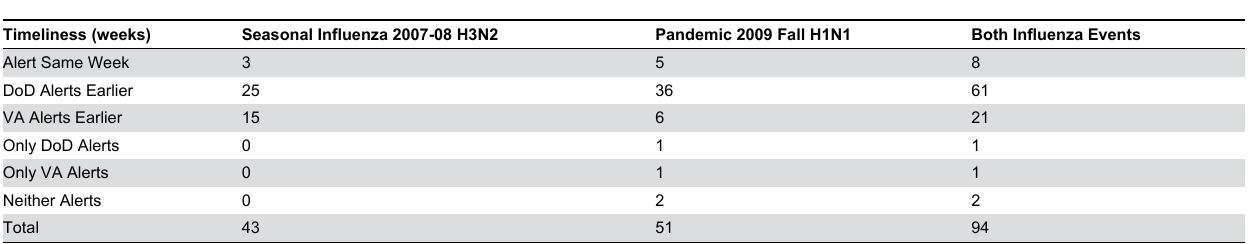
Table 2. Alerting timeliness comparison of Department of Defense (DoD) and Veterans Affairs (VA) outpatient records associated with influenza-like illness (ILI) during two different influenza events and both events combined for Core-Based Statistical Areas (CBSAs) that have both DoD and VA facilities and have at least 10 ILI patients/week stratified by alerting